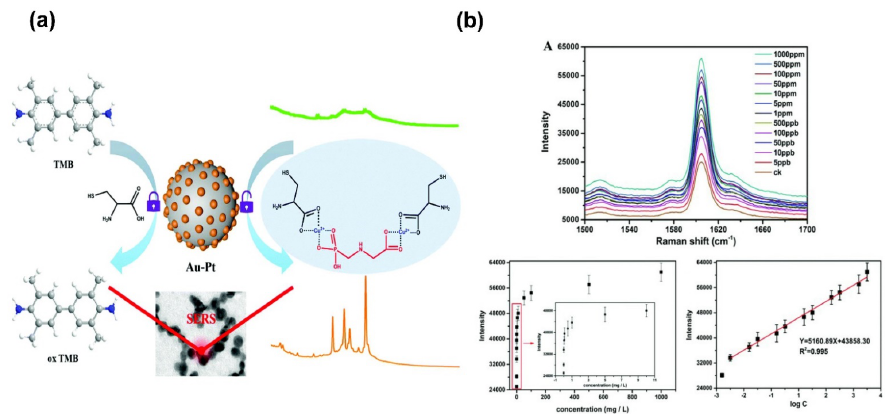
Figure 14. ( a ) Schematic illustration of the sensing process of glyphosate, ( b ) SERS spectra and reference plot of SERS intensities of a Raman shift at 1605 cm −1 vs. GLYP concentrations, and linear plot of SERS intensities of a Raman shift at 1605 cm −1 vs. logarithm of GLYP concentrations. Reprinted with permission from [126]. Copyright 2021 Royal Society Chemistry.